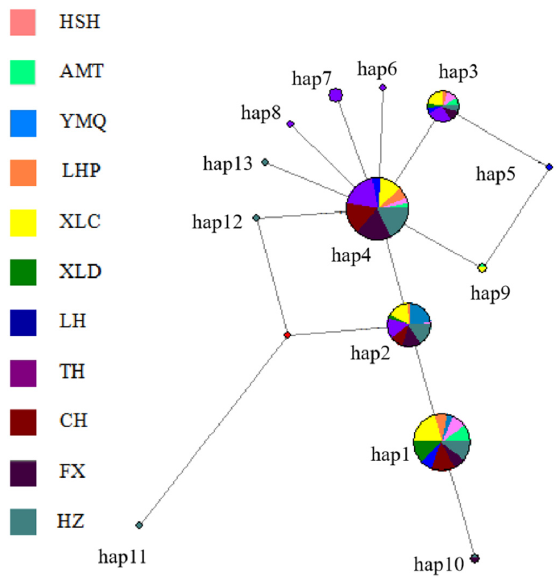
Figure 3. Haplotype network trees of N. taihuensis in different populations.